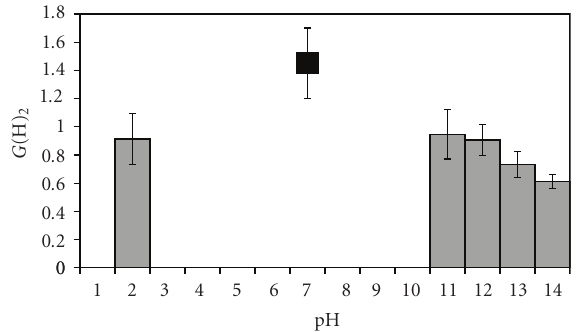
Figure 10: Experimentally measured pH dependence of G (H 2 ), including reported literature values for distilled, deaerated water, shown at pH = 7. Error bars on experimental results indicate 95% confidence